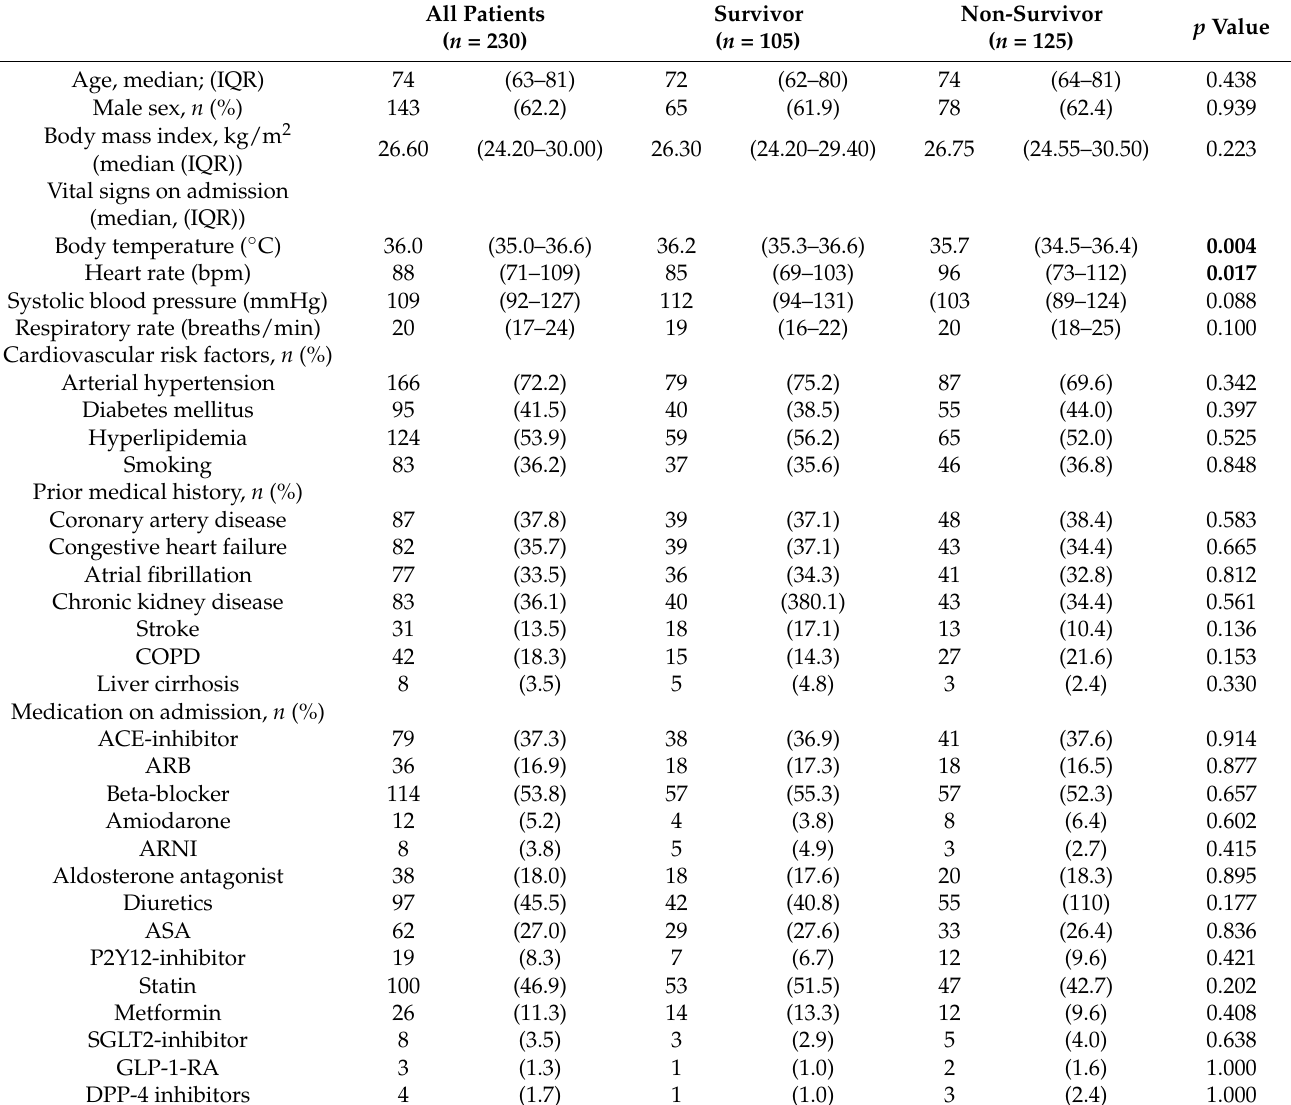
Table 1. Baseline